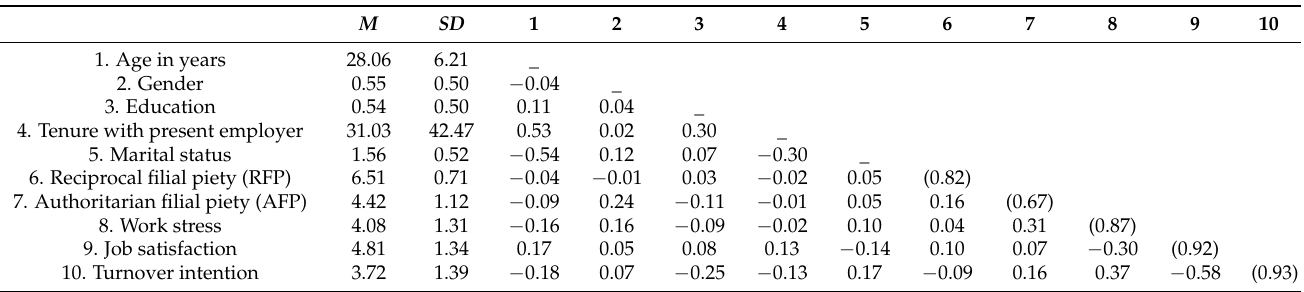
Table 1. Mean, standard deviations, scale reliabilities, and correlations matrix for the whole sample.